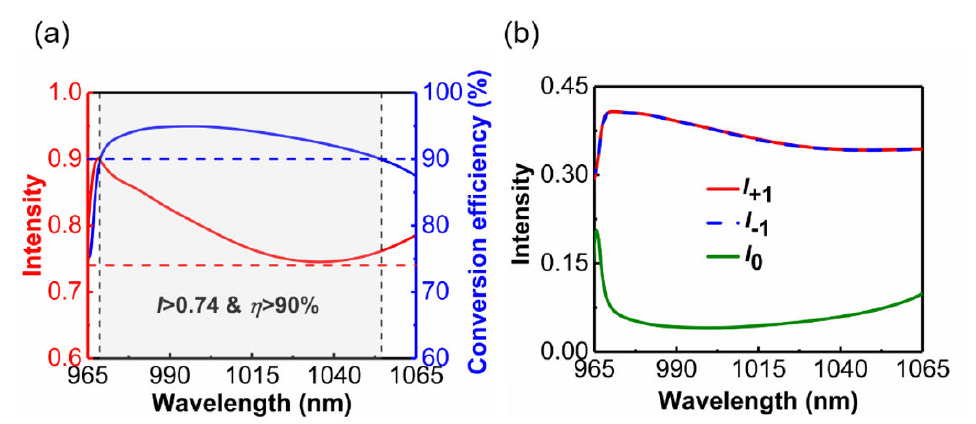
Figure 8. ( a ) Transmission intensity and conversion efficiency of the transmitted beam for x-polarized incidence in the wave range from 965 nm to 1065 nm. The red dashed line indicates that the transmission is 0.74, the blue dashed line represents that the conversion efficiency is 90%. ( b ) Intensity of +1, 0, and − 1 diffraction orders within the wavelength region from 965 nm to 1065